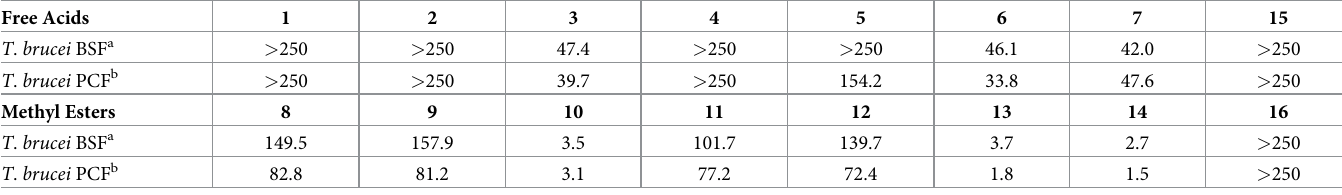
Table 2. Bioactivity of tryptophan derivatives 1–7 and their methyl esters 8–14, as well as natural tryptophan (15) and its methyl ester 16, against T . brucei blood- stream form trypomastigotes (BSF) and T . brucei procyclic form trypomastigotes (PCF). Mean EC 50 values ( μ M) determined from n = 4 replicates, all SD values (not shown) within 10% of EC 50 value.